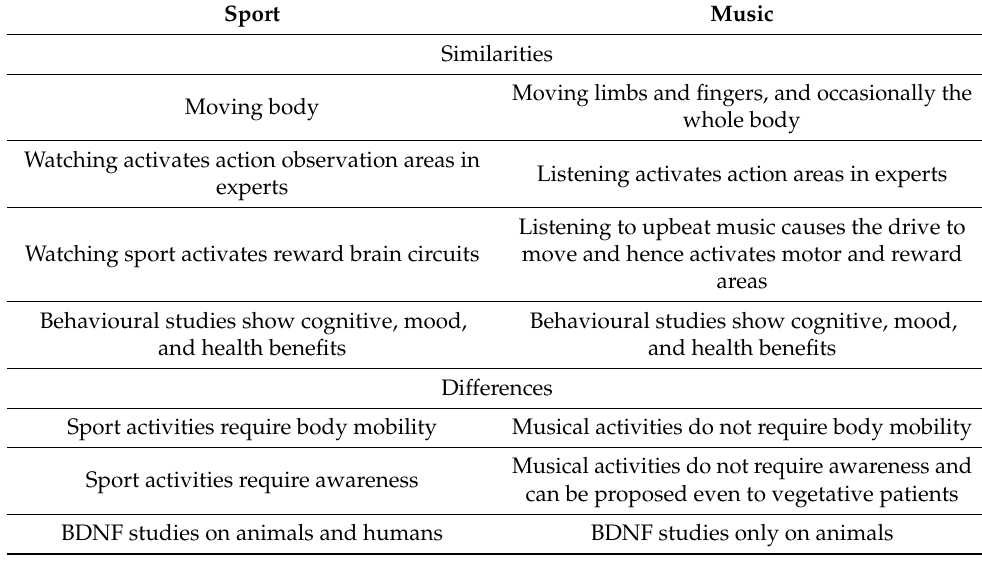
Table 1. Cognitive and motor similarities and differences between sport and musical